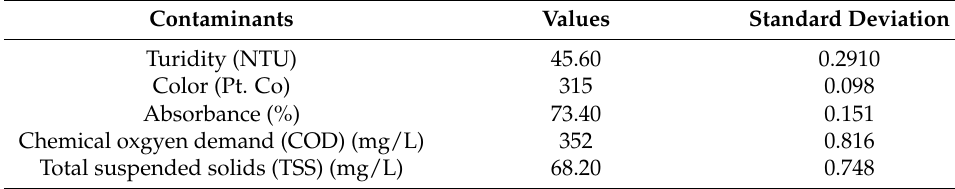
Table 1. Characteristics of wastewater sample composition.